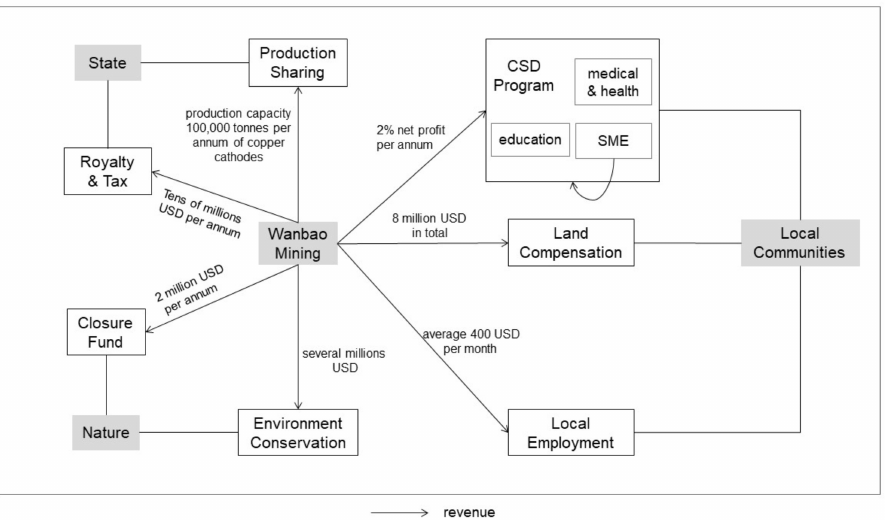
Figure 3. Value distribution in the Letpadaung copper production network. Sources: study